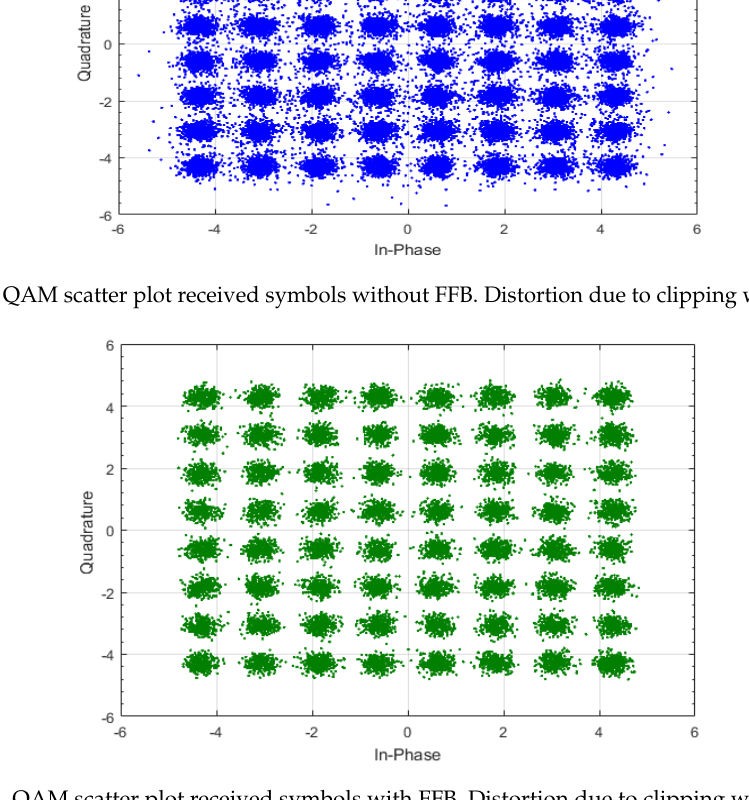
Figure 11. QAM scatter plot received symbols with FFB. Distortion due to clipping with PA model.